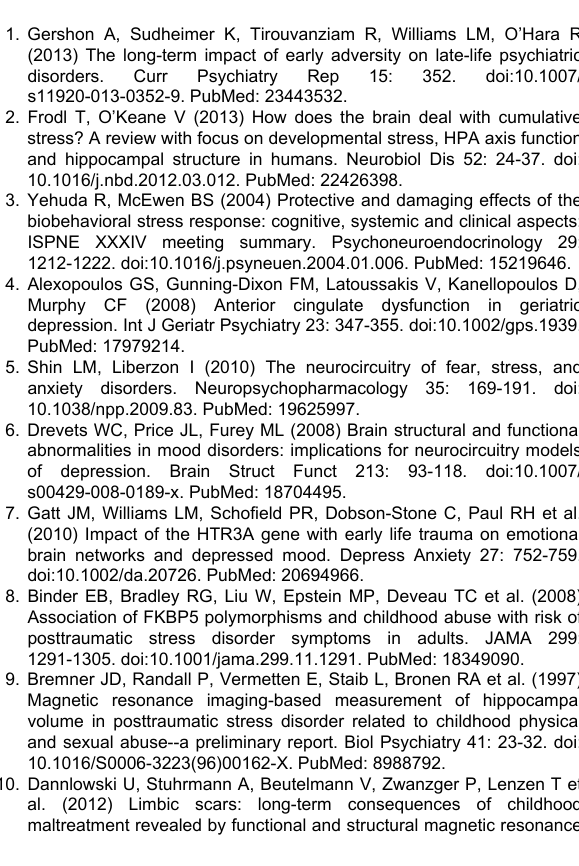
Table S1. Early life stress